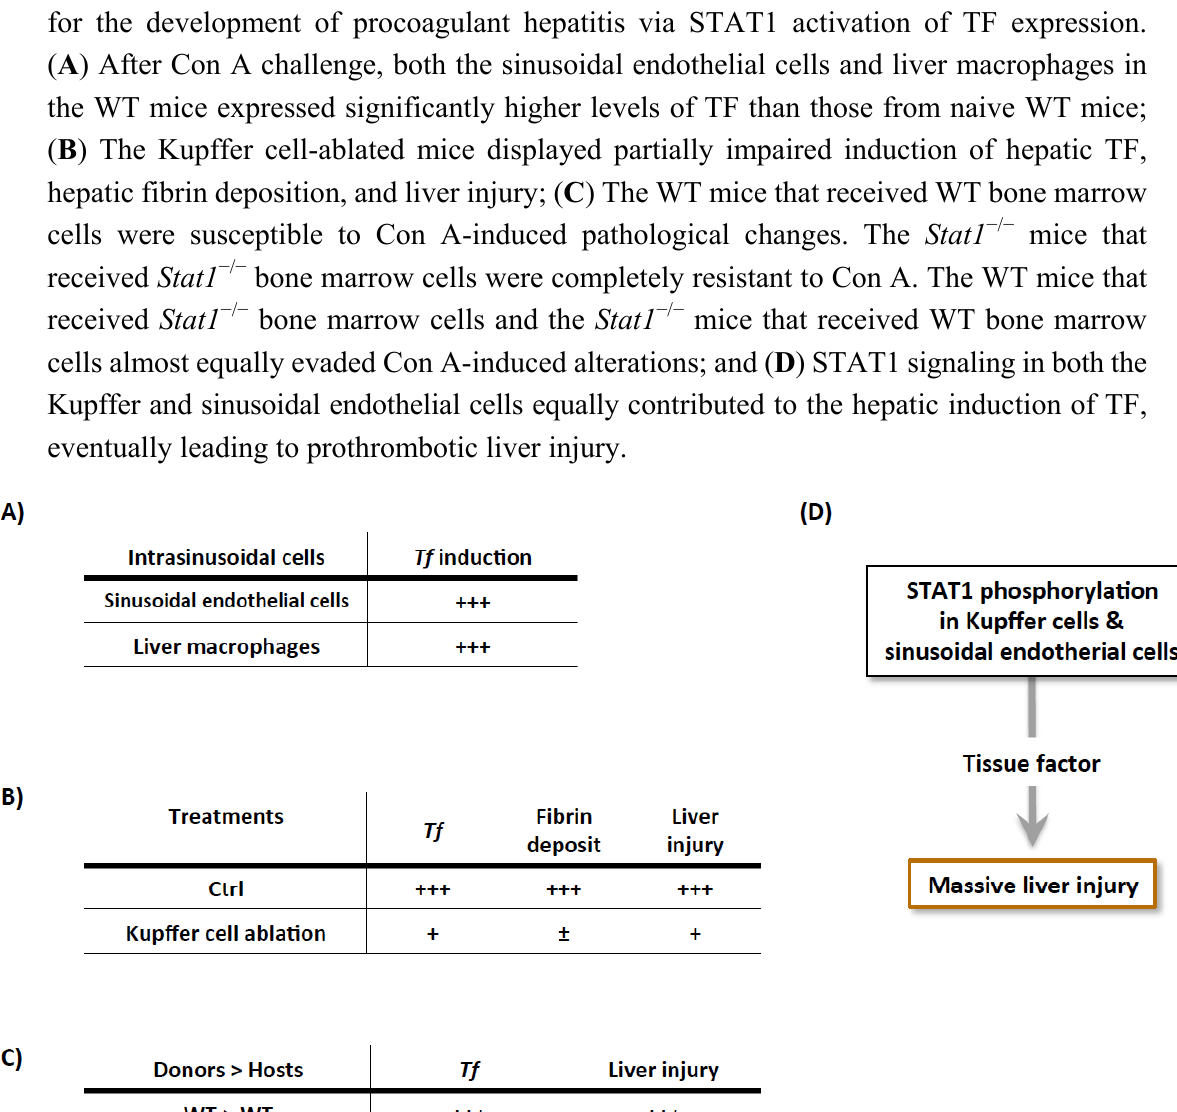
Figure 6. Both hepatic macrophages and sinusoidal endothelial cells are equally required for the development of procoagulant hepatitis via STAT1 activation of TF